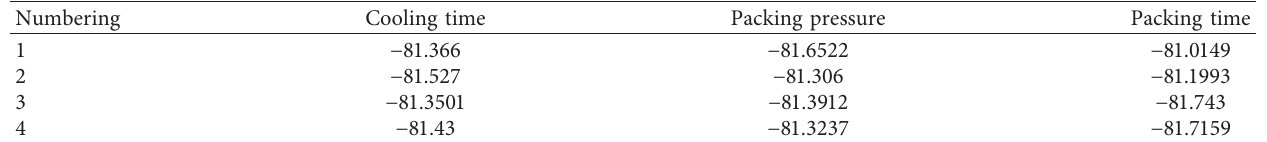
Table 14: Warping SNR analysis of factors C, D, and E.